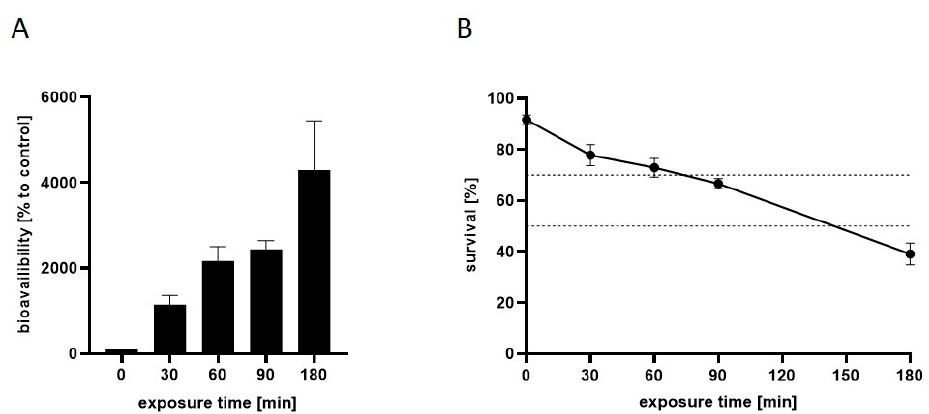
Figure 1. ( A ) Mn bioavailability and ( B ) survival curve of N2 (WT) C. elegans after 100 mM MnCl 2 for up to 180 min. Results show a time-dependent Mn accumulation [% to control] in wild-type nematodes that inversely correlates with the survival rates of the worms analyzed 24 h post-exposure. Data are shown as means ± SEM of four independent experiments.